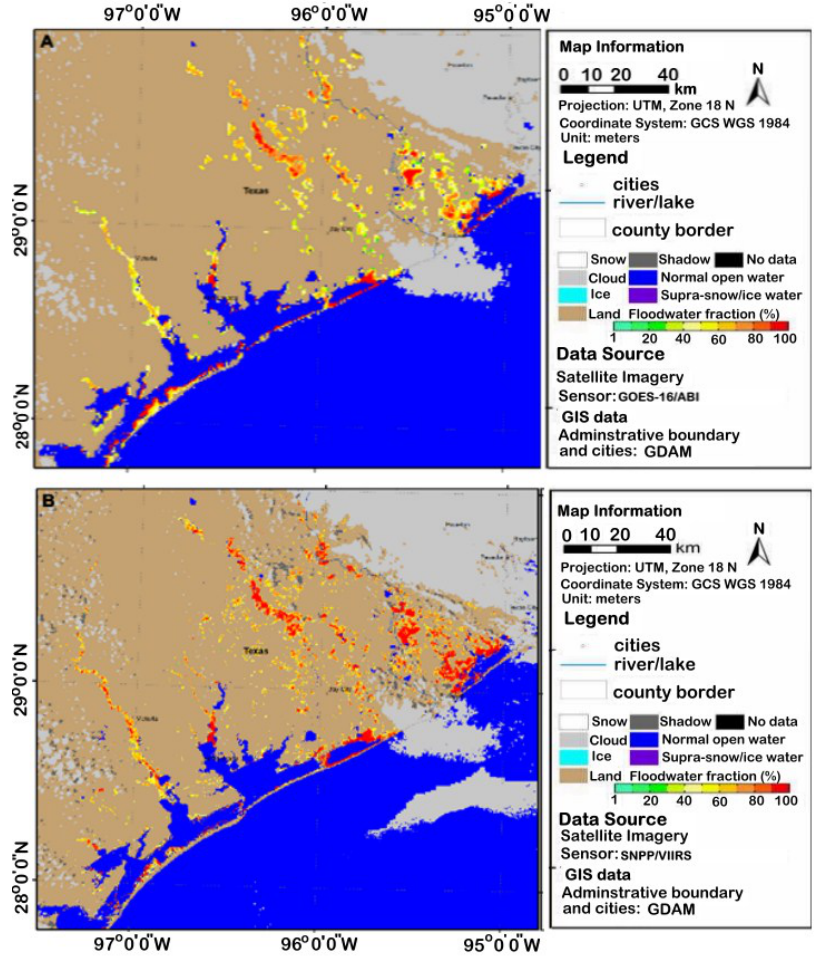
Figure 2. The GOES-16 ABI flood map around 19:02 UTC ( A ) and the SNPP VIIRS flood map at 19:00 UTC ( B ) on 30 August 2017.